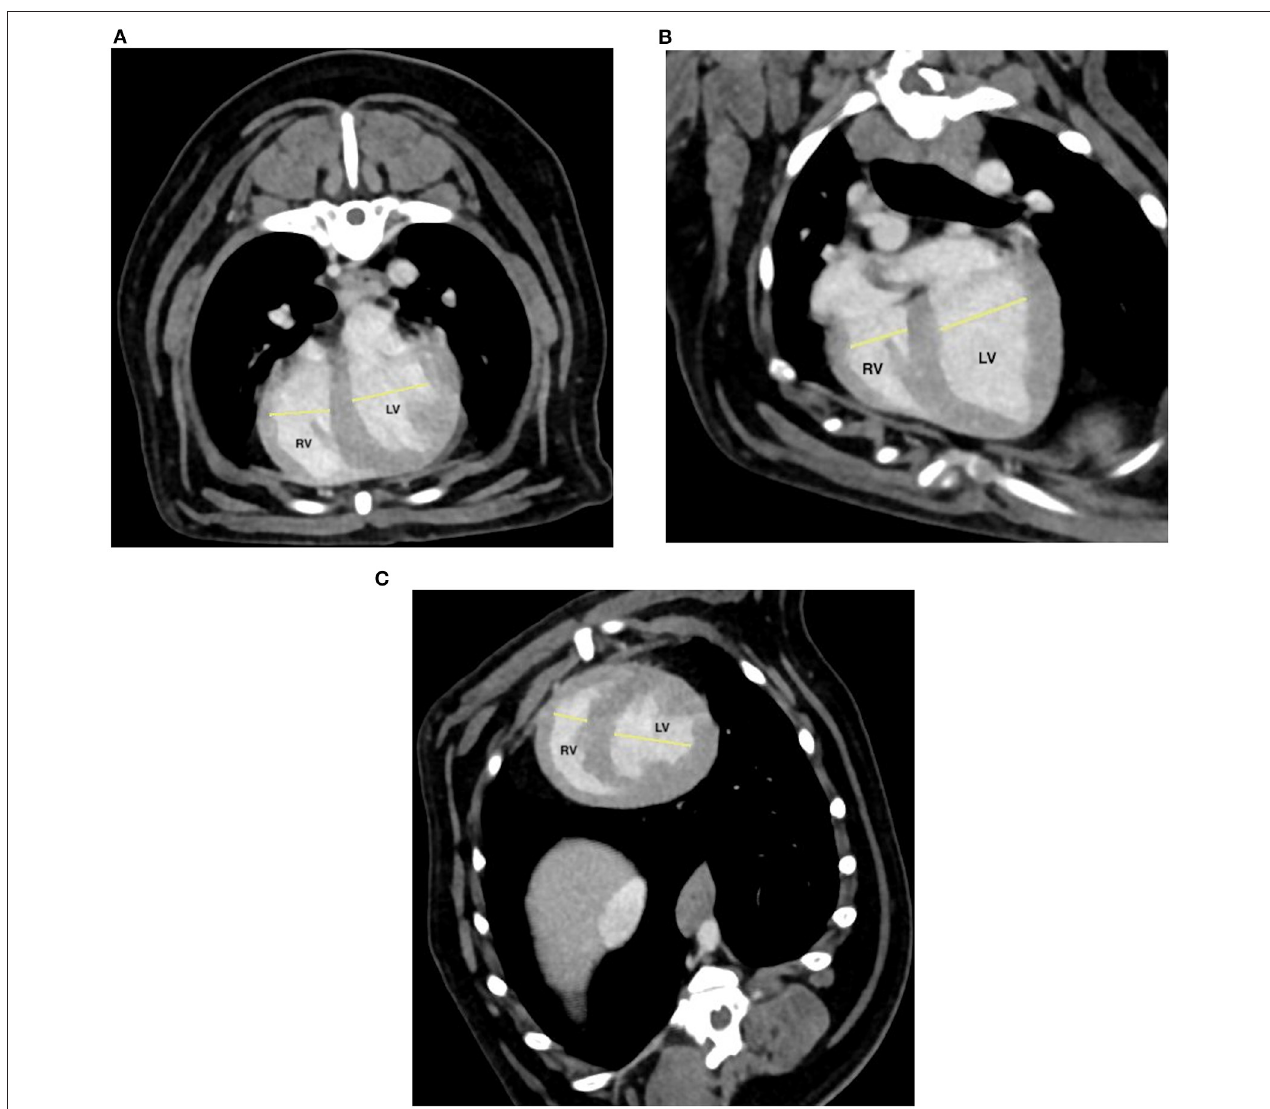
FIGURE 1 | Post-contrast transverse (A) and manually reformatted (B,C) thoracic computed tomographic angiography (CTA) at the level of the ventricles. (B) Standard four-chamber echocardiographic view (4C); (C) standard short-axis echocardiographic view (SA). Right ventricle (RV) and left ventricle (LV) were measured at their largest